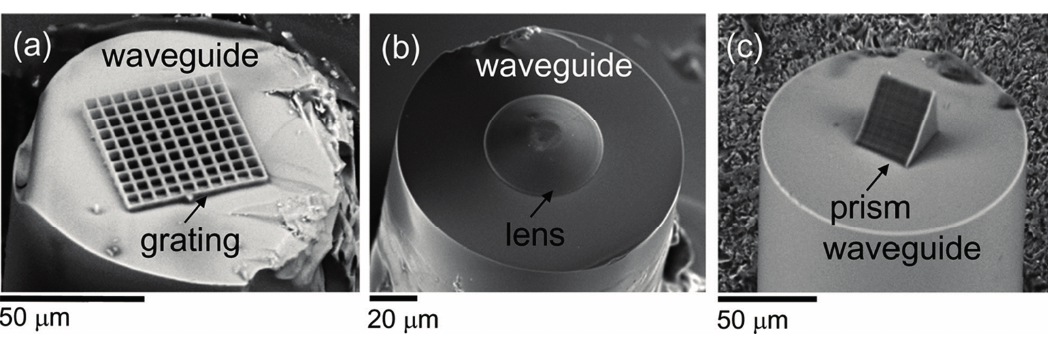
Figure 17. SEM images of ( a ) tilted micrograting; ( b ) microlens; and ( c ) microprism formed by photopolymerization on an optical fiber tip using FsLDW [101] (Reproduced with permission from IOP. © 2012 by the Institute of